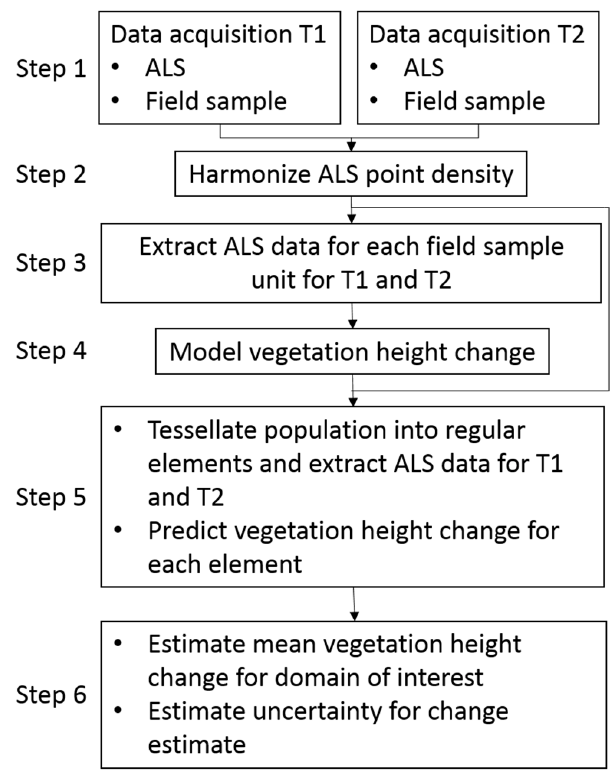
Figure 1. Flowchart of the method to estimate change in vegetation height between the start point (T1) and end point (T2) of an observation period for small domains of interest. ALS: airborne laser scanning.